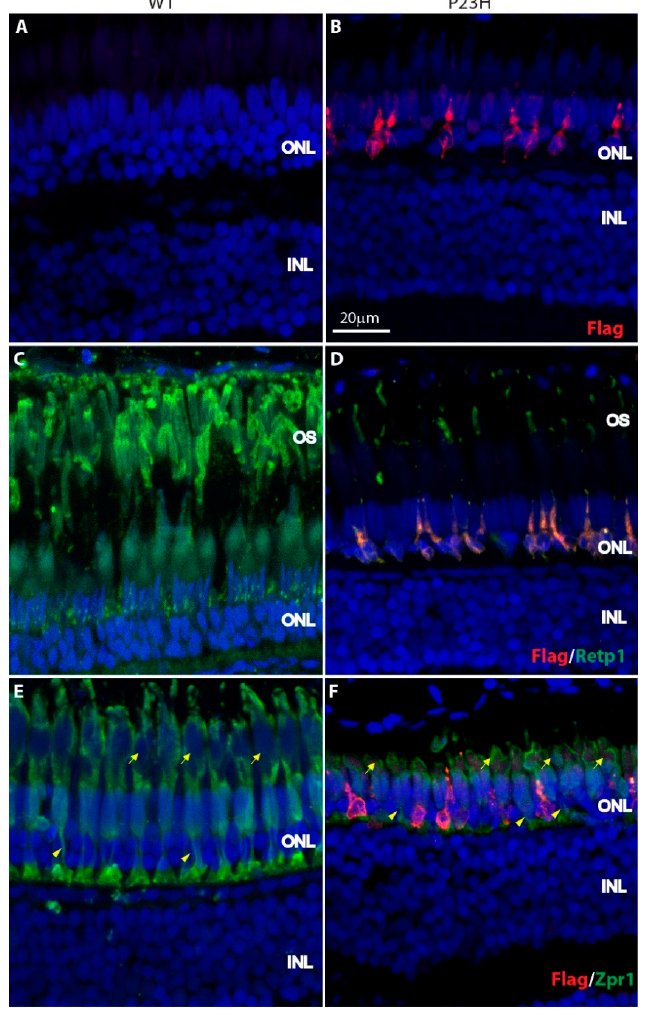
Figure 3. Expression of P23H Flag-tagged rhodopsin in adult zebrafish retina. ( A , B ) The Flag-tagged P23H mutant rhodopsin (red) is expressed by sparsely-distributed photoreceptors in the adult fish ( B ); there is no labeling in wild type fish ( A ). ( C , D ) Mutant rhodopsin (red) colocalizes with rhodopsin (Retp1, green) in the rods. ( E , F ) Mutant rhodopsin (red) is expressed only by the rods and not the cones, as seen with the cone marker Zpr1 (green). Yellow arrowheads represent the cone axons and yellow arrows represent the cone myoids. ONL: outer nuclear layer; INL: inner nuclear layer; OS: outer segments. Scale bar in B applies to all